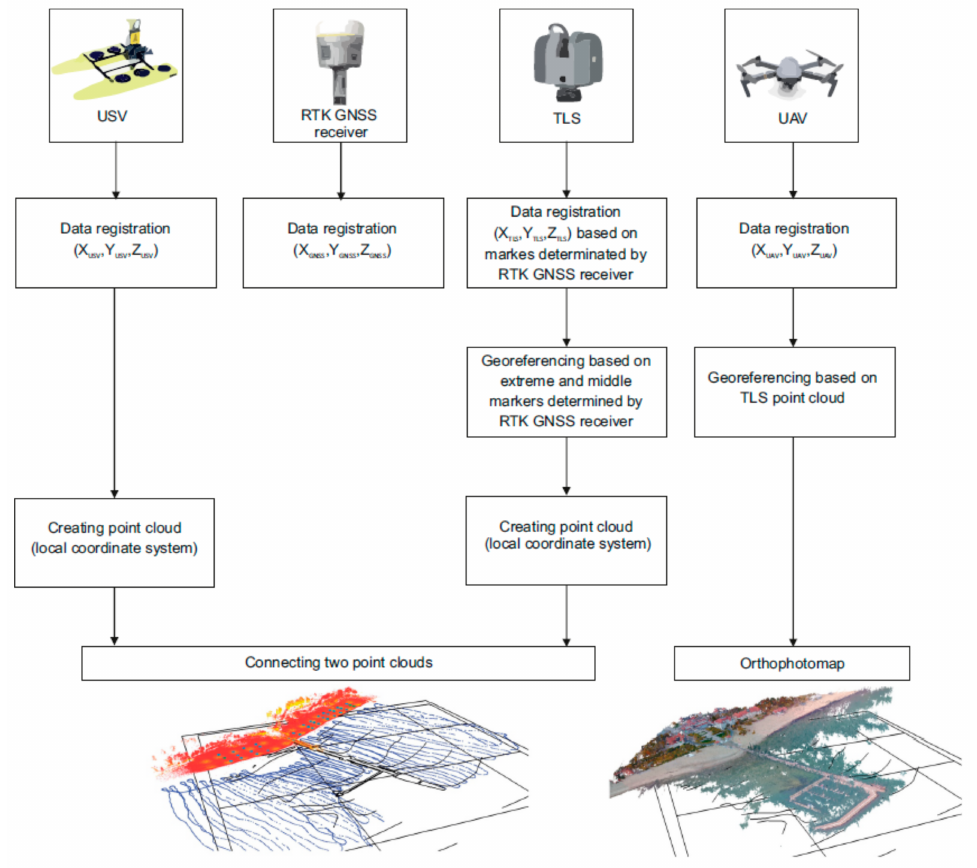
Figure 4. A simplified block diagram showing the data integration during the tombolo (salient) measurement campaign in Sopot in